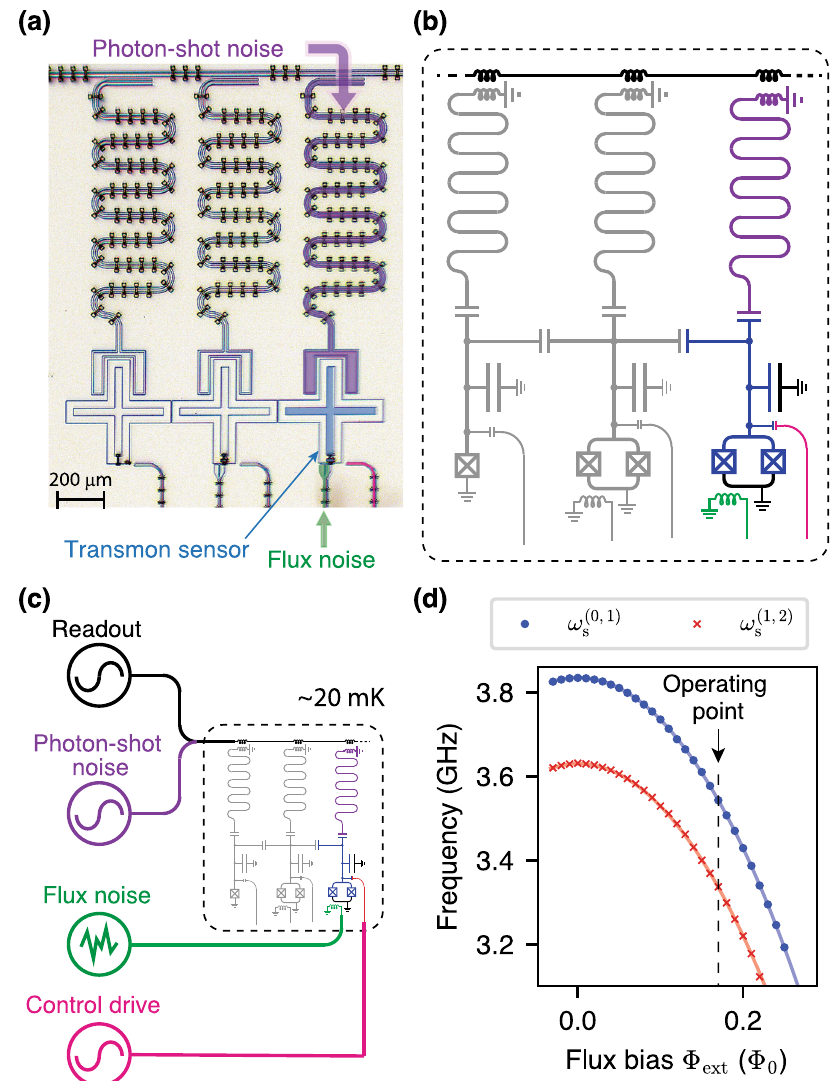
Fig. 2 Device layout and simplifed experimental setup. a Optical micrograph (false color) of the superconducting circuit comprising a fl ux-tunable transmon sensor (blue) to measure fl ux noise and photon shot noise applied via independent channels (green and purple, respectively). The transmon is controlled via a capacitively coupled drive line (magenta). b Circuit schematic. The additional transmon qubits (gray) are far detuned from the frequency of the transmon sensor and can be neglected in this experiment. c Simpli fi ed measurement schematic. Known, engineered fl ux noise and photon-shot noise is applied to the qubit. The control and readout lines are used to perform noise spectroscopy protocol and measure the results. d 0 j i – 1 j i transition frequency (blue circles) and 1 j i – 2 j i transition frequency (red crosses) of the transmon sensor as a function of the external fl ux bias Φ ext . Solid lines correspond to simulations based on the circuit parameters (see Supplementary Note 1). The transmon sensor operates at a fl ux-sensitive point, Φ ext = 0.17 Φ 0 , See dashed black